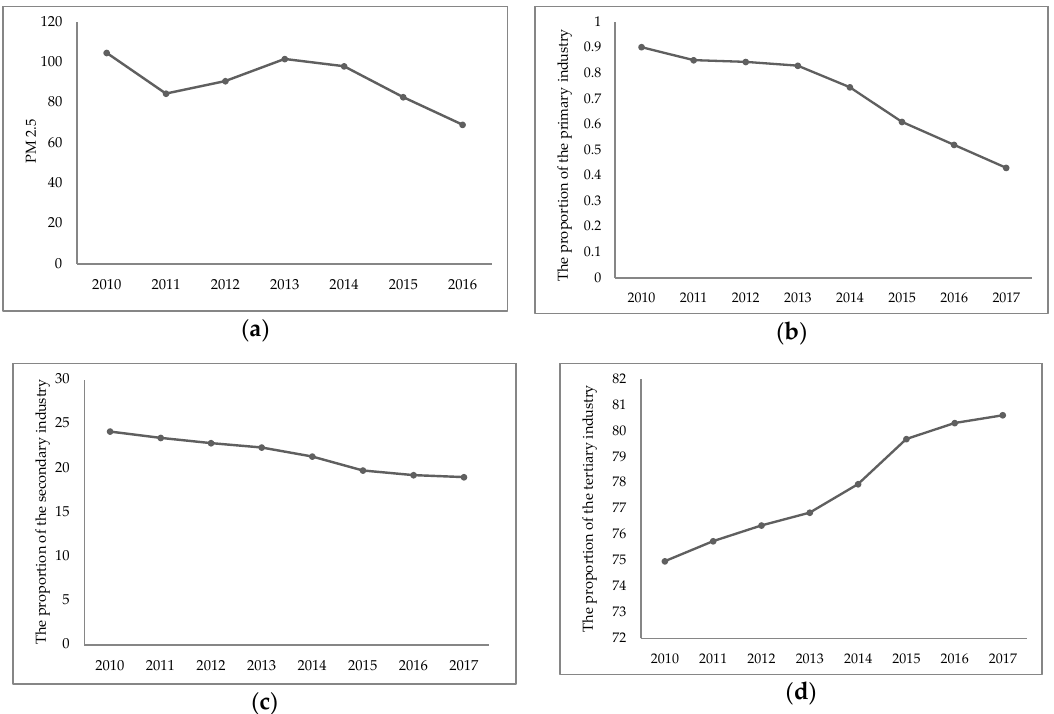
Figure 3. PM 2.5 concentration and annual changes in the proportion of the three industries. ( a ) Annual changes of PM 2.5 concentration. ( b ) Annual changes in the proportion of the primary industry GDP. ( c ) Annual changes in the proportion of the secondary industry GDP. ( d ) Annual changes in the proportion of the tertiary industry GDP.